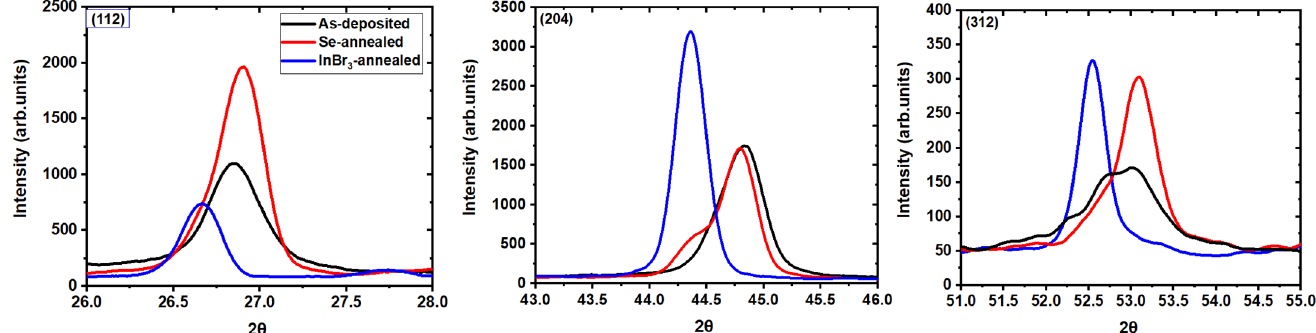
Figure 5. XRD plots of the three key CIGS peaks ((112), (204) and (312)) for the as-deposited (black), Se-annealed (red), e and InBr 3 annealed (blue) at 500 °C CIGS samples.